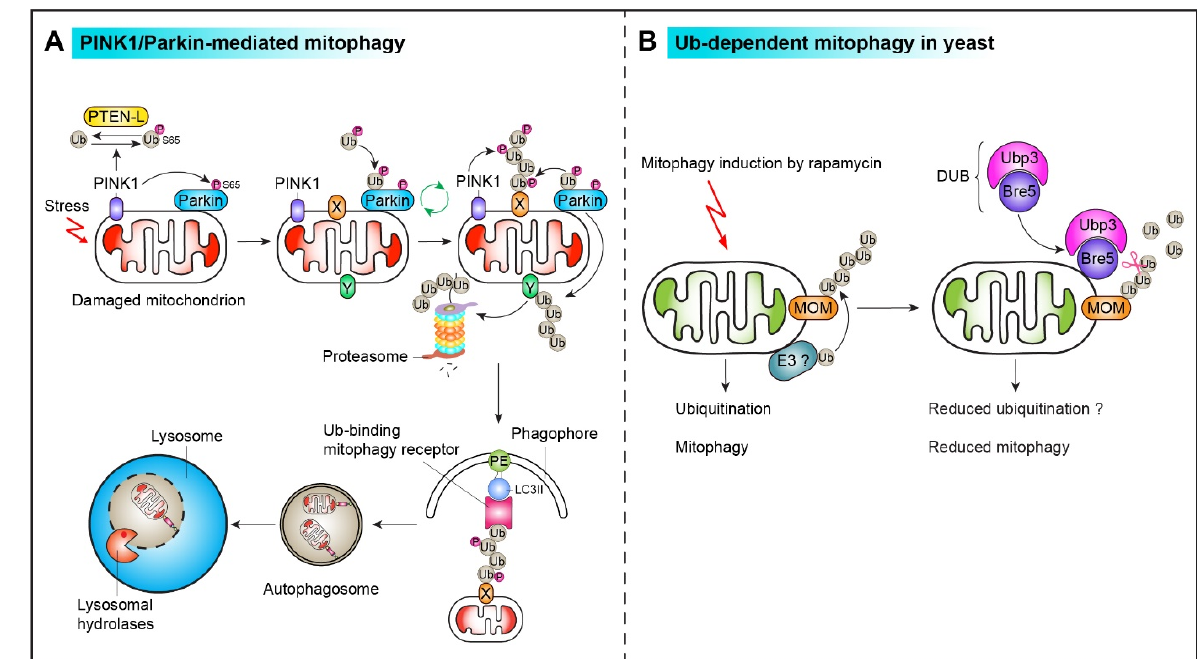
Figure 4. Ubiquitin-dependent mitophagy in mammals and yeast. ( A ) The PINK1–PARKIN pathway. Upon mitochondrial damage, PINK1 kinase is stabilized on the mitochondrial surface and recruits the E3 ubiquitin ligase PARKIN. PINK1 phosphorylates both ubiquitin (Ub) and PARKIN at the residue Ser65 and generates pSer65-Ub and pSer65-PARKIN, respectively. Mitochondrial localization of PARKIN and its ubiquitin ligase activity is enhanced drastically ( ∼ 4400-fold) when pSer65-Ub binds to pSer65-PARKIN. This can create a feedforward loop by providing additional ubiquitin molecules for PINK1 phosphorylation. Some PARKIN substrates (labeled as “Y”) are degraded by the ubiquitin-proteasome system (UPS) during mitophagy. Mitochondria decorated with polyubiquitin/phospho-ubiquitin chains (shown on “X”) are recognized by ubiquitin-binding mitophagy receptors and sequestered by autophagosomes for lysosomal degradation. ( B ) Ub-dependent mitophagy in yeast. Upon mitophagy induction in respiring cells with treatment with rapamycin, mitochondrial outer membrane (MOM) proteins can be ubiquitinated by unknown E3 ubiquitin ligase(s). The autophagy machinery recognizes ubiquitinated mitochondria for subsequent vacuolar degradation. The cytosolic Ubp3-Bre5 deubiquitinase complex can inhibit mitophagy when it is recruited to mitochondria presumably by removing ubiquitin moieties from MOM